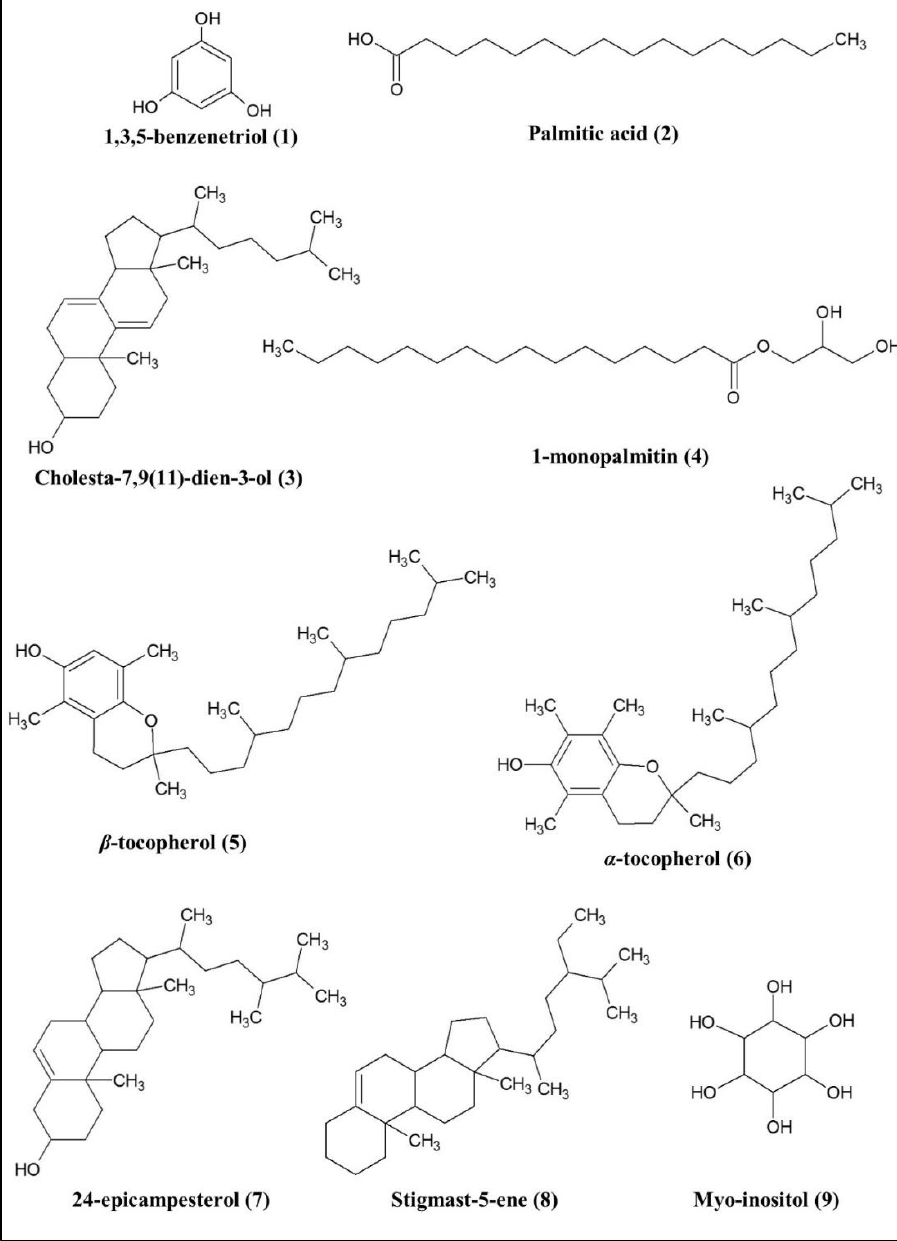
Figure 3. Chemical structures of putative metabolites identified by GC-MS-based metabolomics.